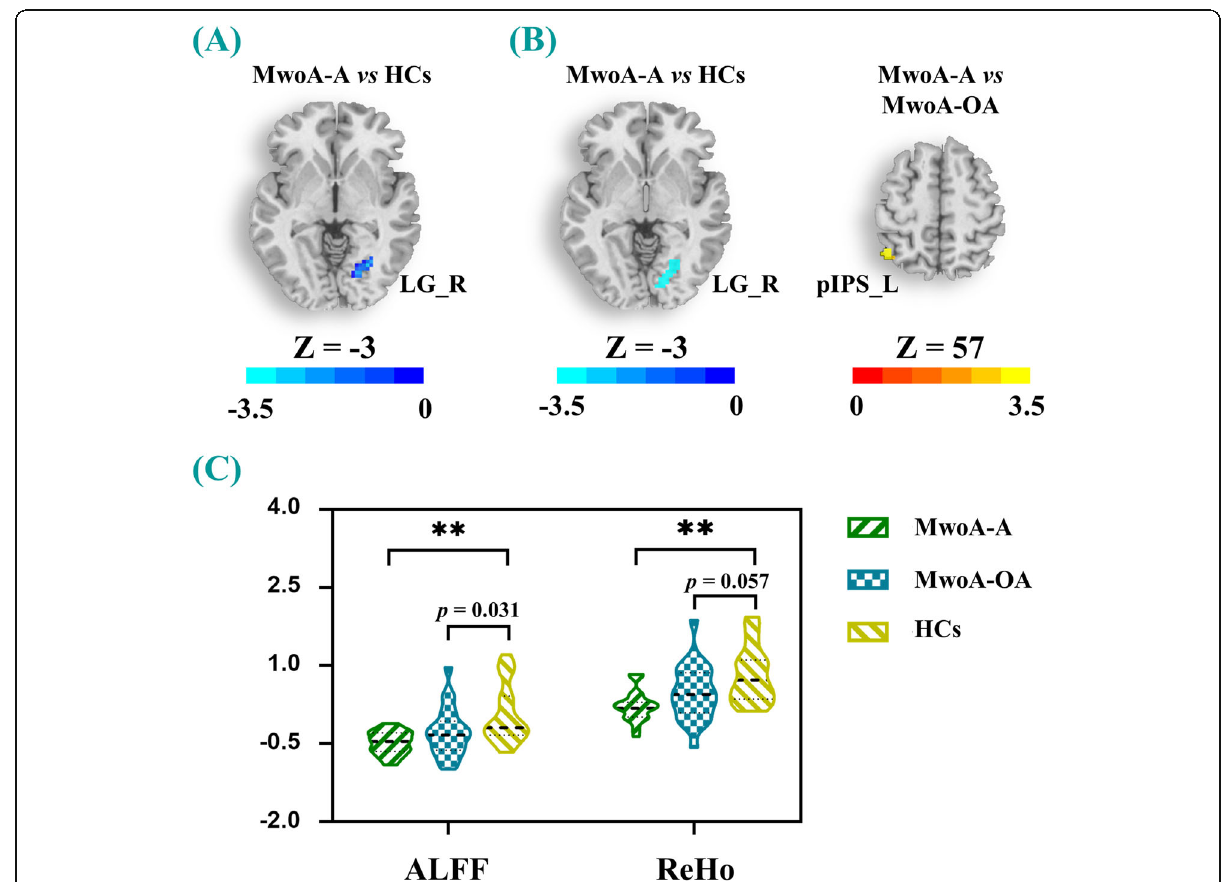
Fig. 1 a - b Brain maps showed differences in ALFF and ReHo respectively among the three groups (MwoA-A, MwoA-OA and HCs). c The violin plot displayed the ALFF and ReHo values of the right LG in the three groups. ** means p < 0.005 ( Bonferroni corrected). Warm and cool colors, respectively, indicate increase and decrease of ALFF and ReHo values in the right LG. Cool color represents decreased ALFF and ReHo values, and warm color represent increased ReHo values. All abbreviations are defined in the Abbreviations section